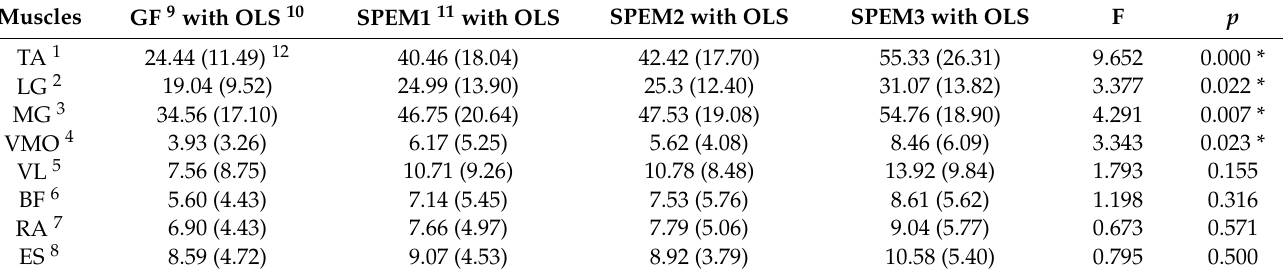
Figure 4. Comparison for four exercises on the center of pressure (surface area ellipse, length, and average speed). * Statistical significance p < 0.05. Table 3. Comparison of four exercises on the trunk and lower extremity muscle